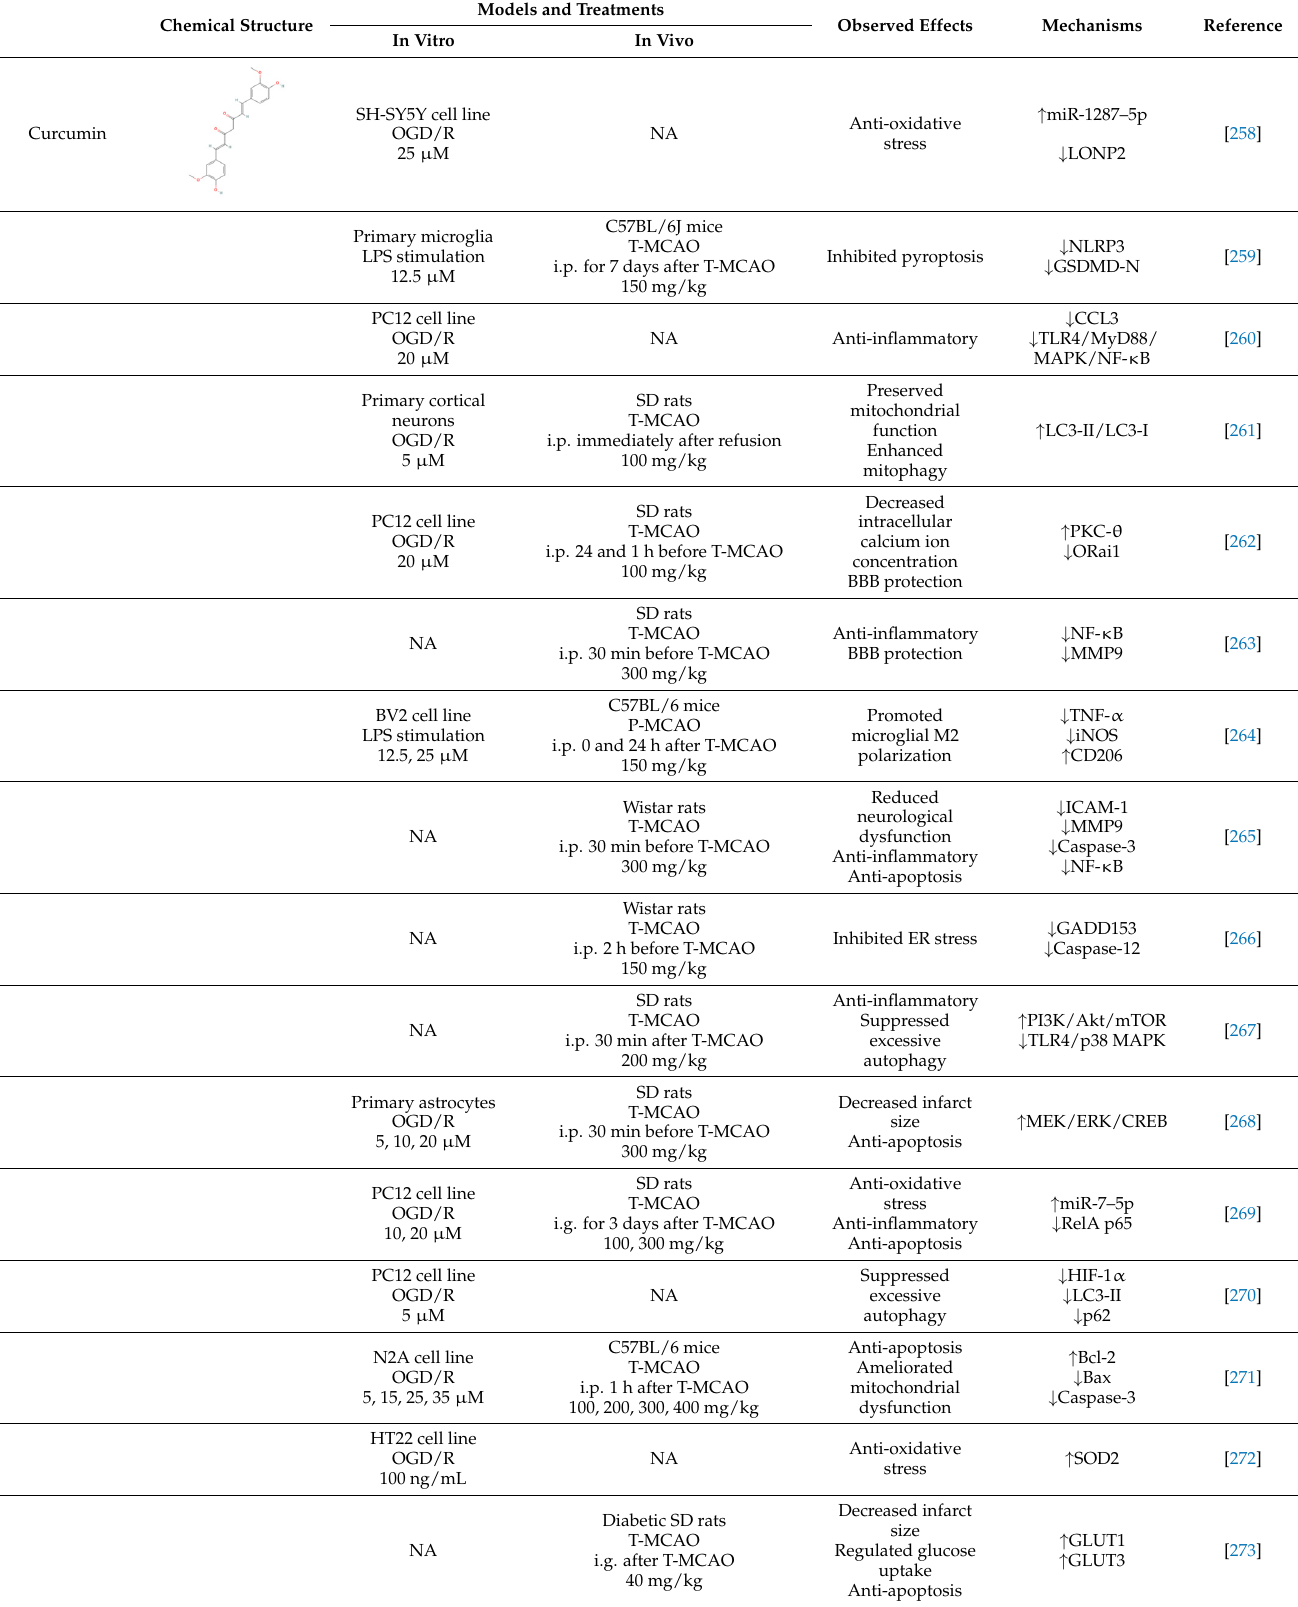
Table 5. Summary of recent studies on anti-IS effects of curcumin.